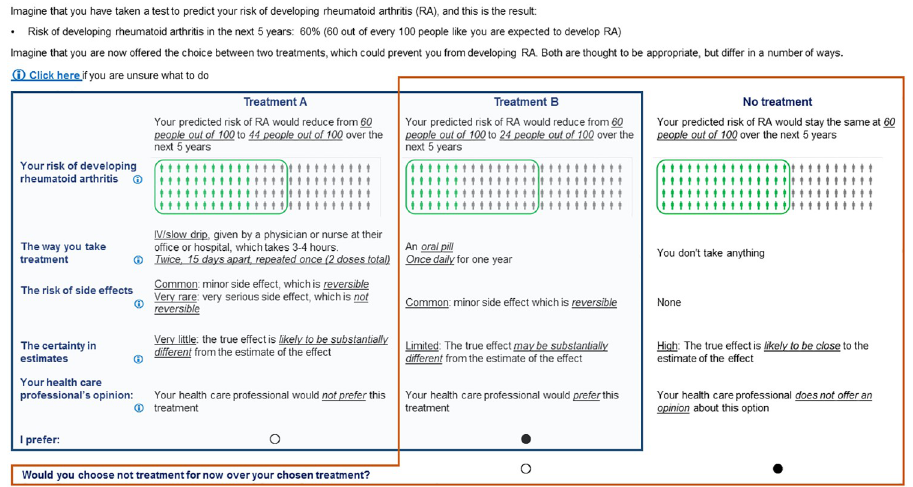
Fig 1. Example choice set completed by respondents. Footnote: Blue box–Part one, forced choice question, the participant chooses their preferred treatment between treatment A and treatment B; Orange box—Part two, opt out component, the participant decides whether they would take their preferred treatment of no treatment; ‘Click here’ allows the participant to view the entire informational video which was provided as part of the background instructions one more time; ‘i’ allows the participant to see the segemt of the information video relating to that particular attribute one more time; Underlined text within treatment A, treatment B, or no treatment descriptions is for emphasis